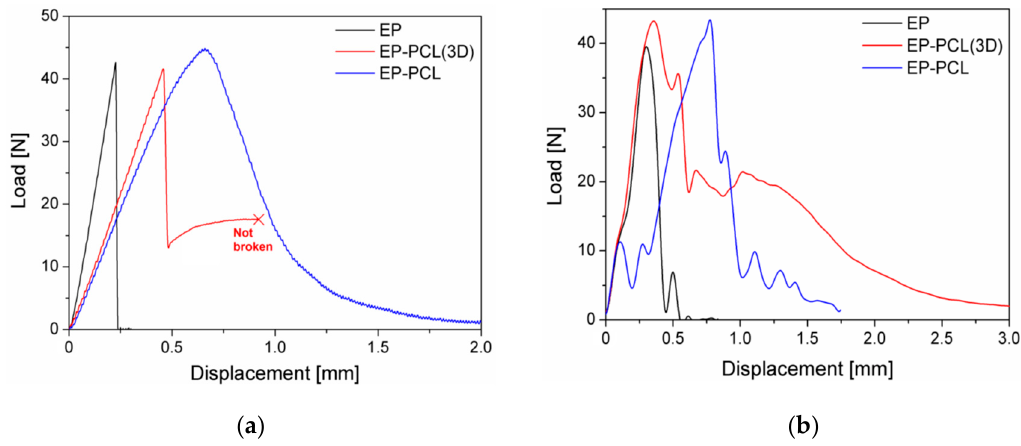
Figure 4. Representative load–displacement curves of EP, EP-PCL(3D) and EP-PCL samples obtained from three-point bending tests for fracture toughness evaluation. ( a ) Quasi-static conditions, ( b ) impact conditions.